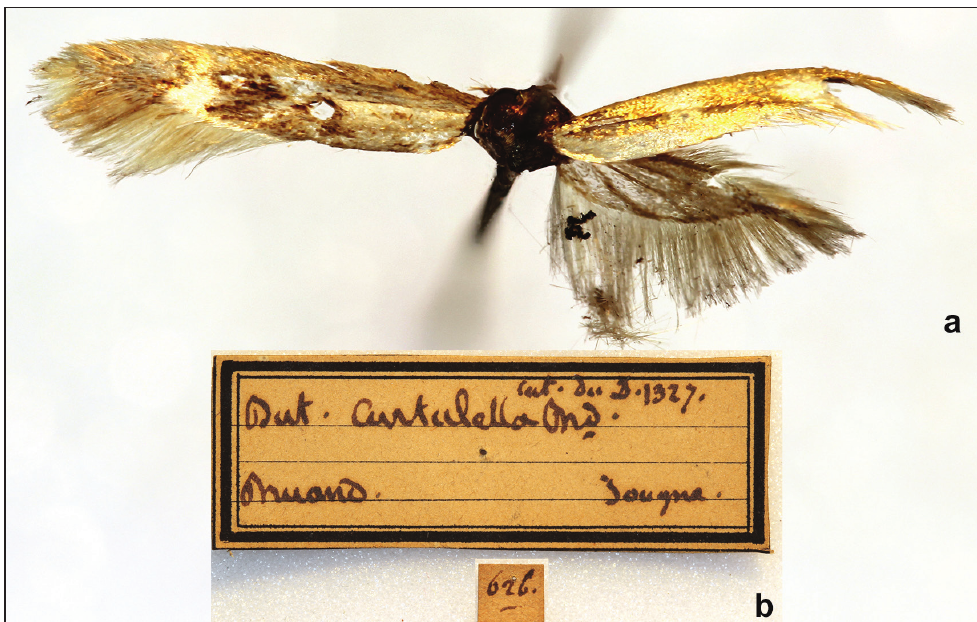
Figure 2. Holotype of Scythris curtulella (Bruand, 1851). a – wingspan 14 mm; b – original